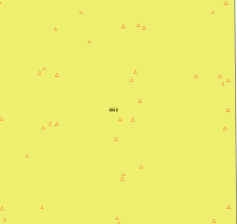
Figure 2. Distribution of control points in the study area